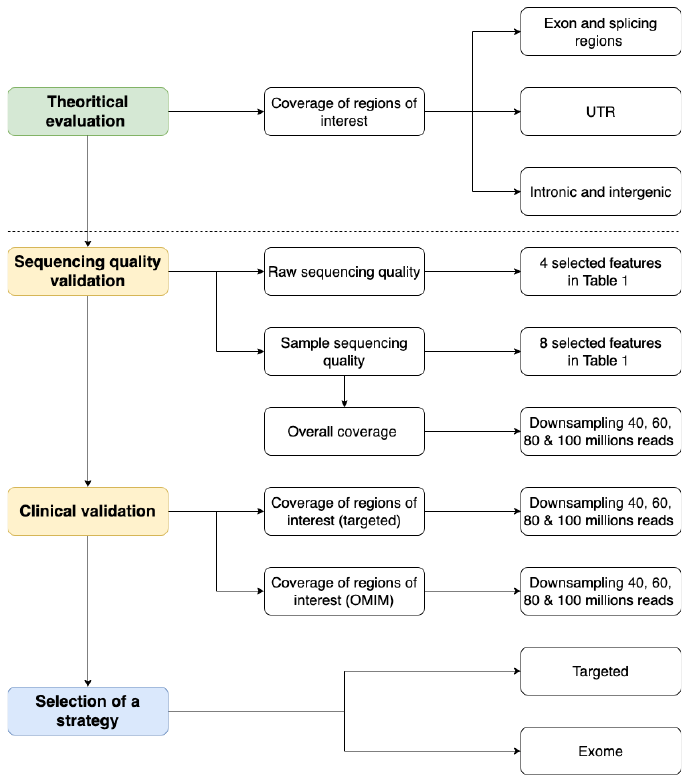
Figure 1. Evaluating the transition from targeted to exome sequencing workflow.